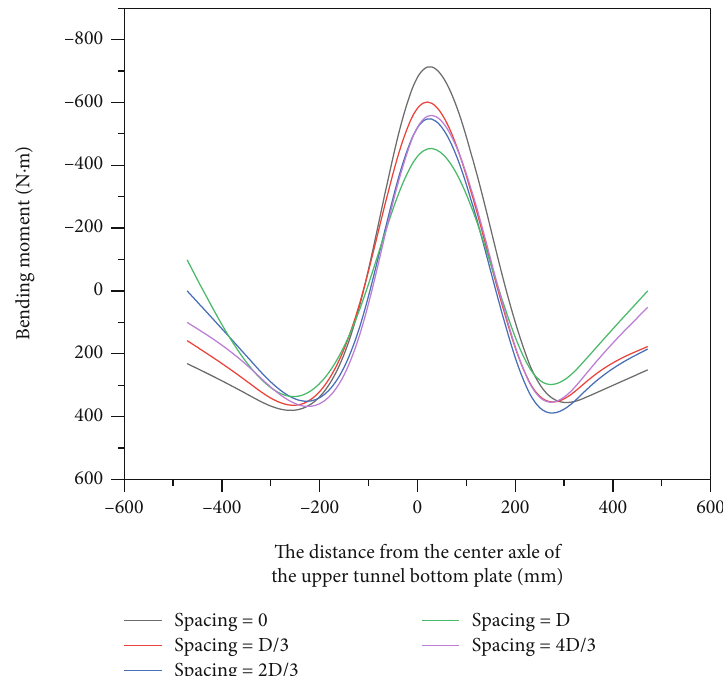
Figure 13: Bending moment curve of upper tunnel fl